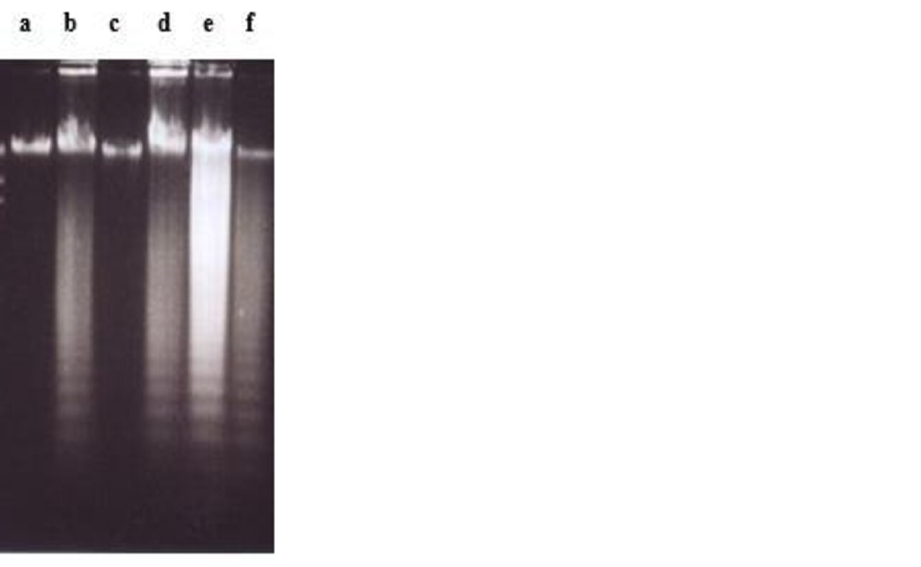
Figure 12. The involvement of increase in cytosolic calcium concentration and phosphatases in damnacanthal-induced apoptosis in CEM-SS cells at 24 h. EGTA and okadaic acid failed to prevent apoptosis induced by 30 µ g/mL of damnacanthal at 24 h. Lane a: control. Lane b: damnacanthal (30 µ g/mL). Lane c: EGTA (0.5 mM). Lane d: damnacanthal (30 µ g/mL) + EGTA (0.5 mM). Lane e: okadaic acid (100 nM). Lane f: damnacanthal (30 µ g/mL) + okadaic acid (100 nM). Lane M: Marker (HindIII digest of lambda DNA).